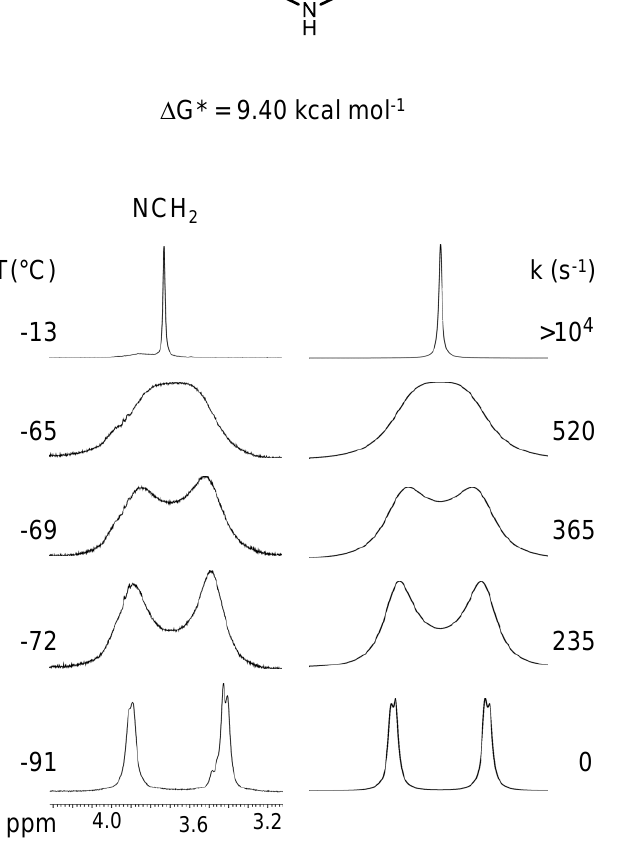
Figure 3. 1 H NMR spectra at 500 MHz in CD 2 Cl 2 for the signals of the two benzylic hydrogens of biphenylazepine 1 . Experimental traces are shown on the left and the computer simulated ones on the right.